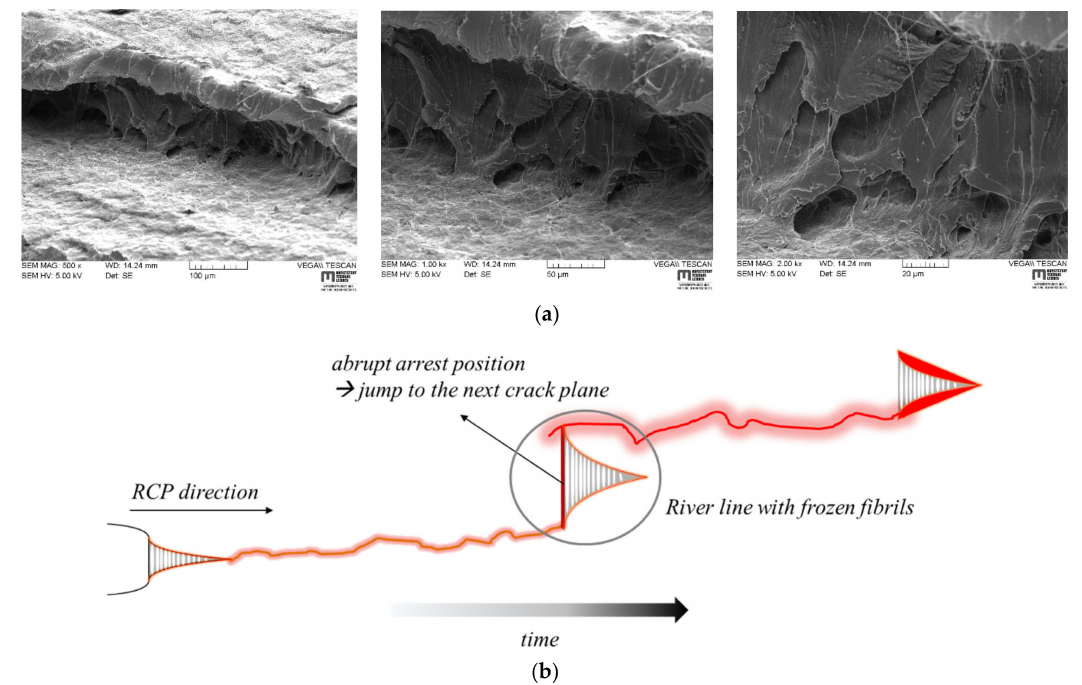
Figure 8. Fibrillar structures beneath river lines with increasing magnification ( a ) and schematic representation of how these structures could have evolved ( b ).